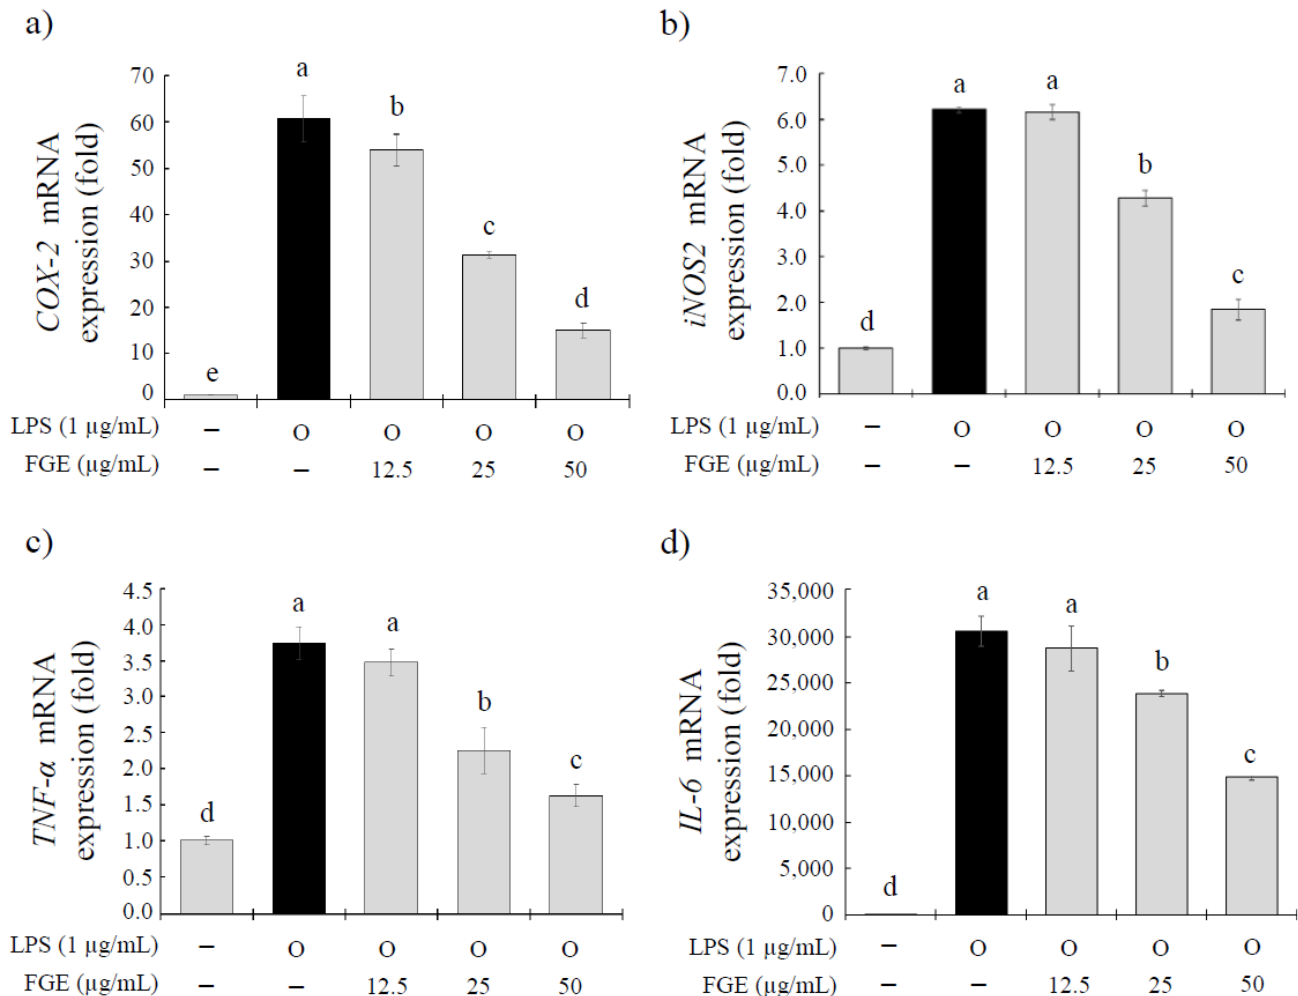
Figure 2. Effect of Filipendula glaberrima Nakai extract on the expression of ( a ) COX-2 , ( b ) iNOS2 , ( c ) TNF- α , and ( d ) IL-6 genes in LPS-treated RAW 264.7 macrophages. RAW 264.7 cells were treated with each sample for 30 min, and then LPS (1 µg/mL) was stimulated for a further 24 h. The mRNA expressions were analyzed by qRT-PCR. The results are expressed as the mean ± S.D. of three independent tests in triplicate. Different superscripts mean a significant difference among the groups ( p < 0.05) based on one-way ANOVA and Duncan’s multiple range test. FGE, ethanol extract of Filipendula glaberrima Nakai; COX-2 , cyclooxygenase-2 ; iNOS2 , inducible nitric oxide synthase 2 ; TNF- α , tumor necrosis factor-alpha ; IL-6 , interleukin-6